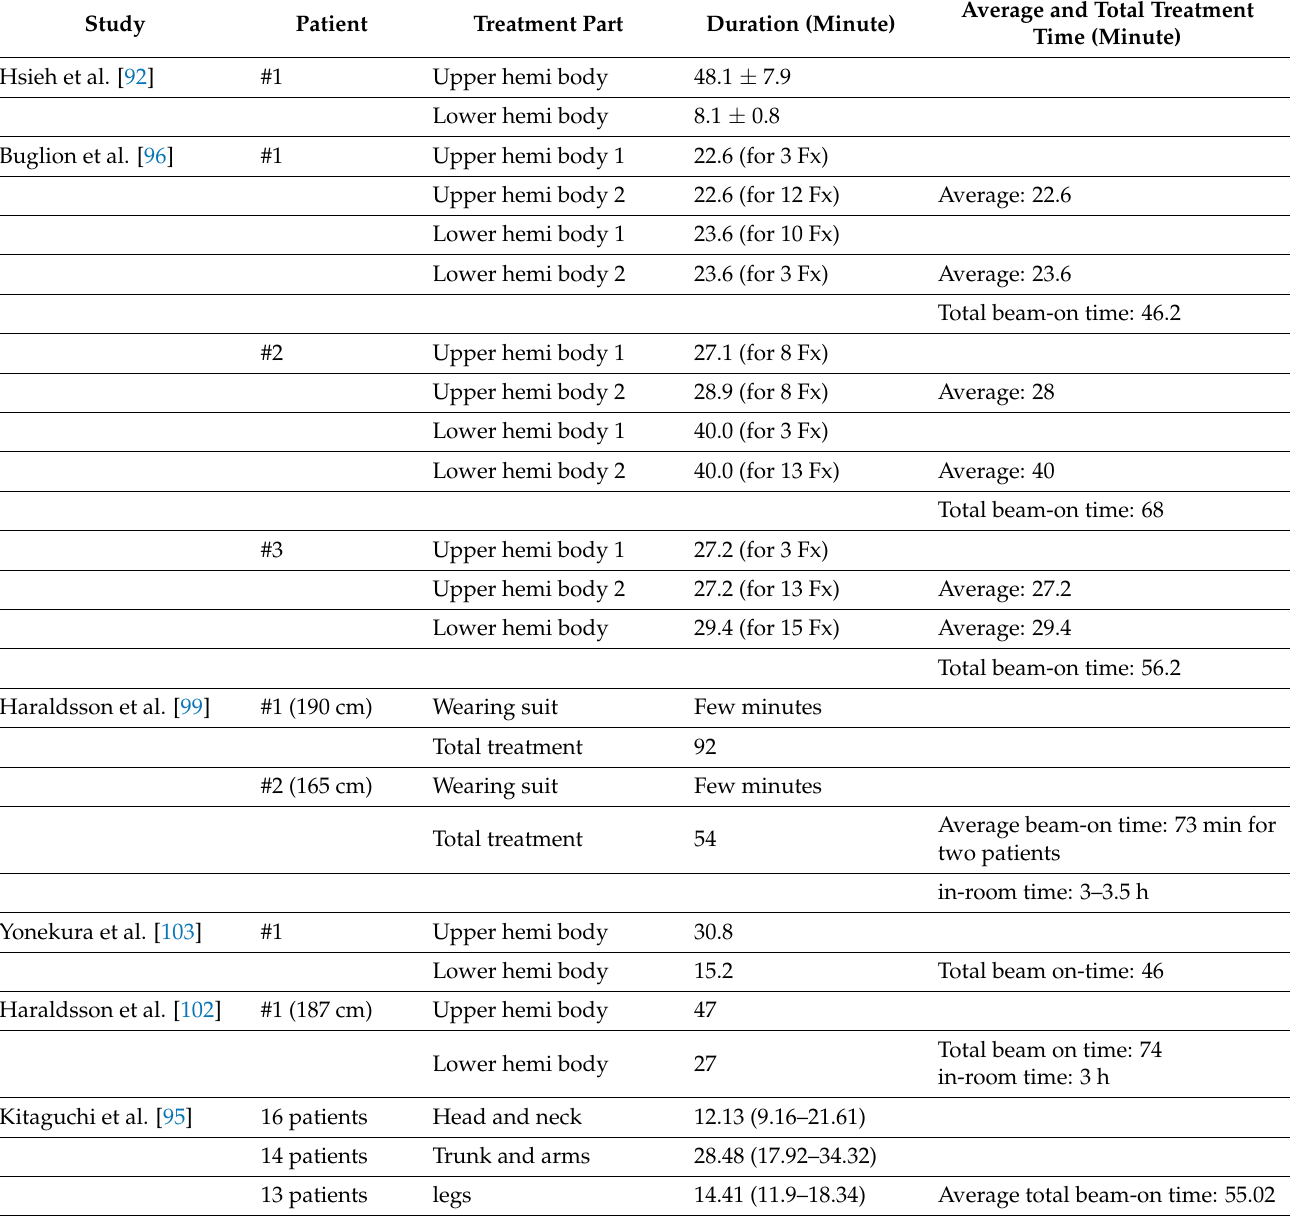
Table 4. Treatment time for total skin irradiated by helical